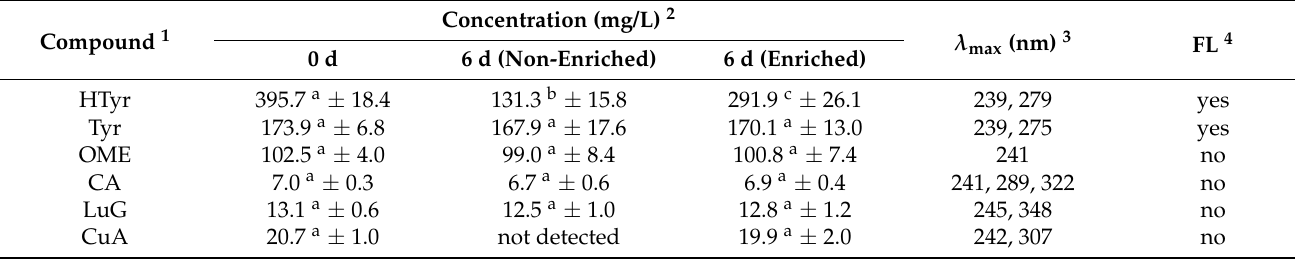
Table 6. Content of individual phenolic/secoiridoid compounds in non-sterile washing waters (non-enriched or nutrient- enriched) prior and after fermentation at the maximum β -carotene production by B. trispora (fermentation time: 6